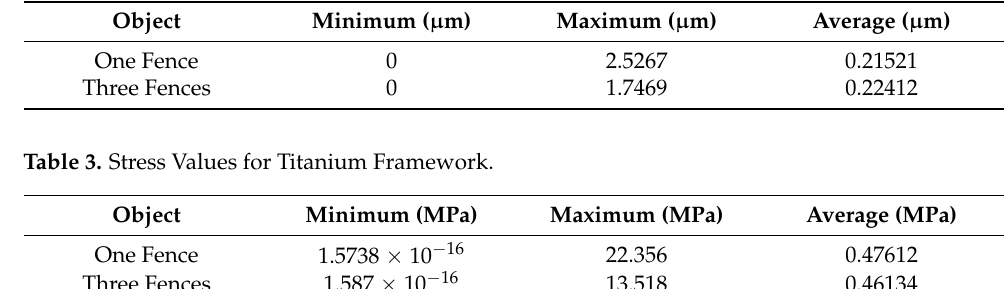
Table 2. Deformation Values for Titanium Framework.